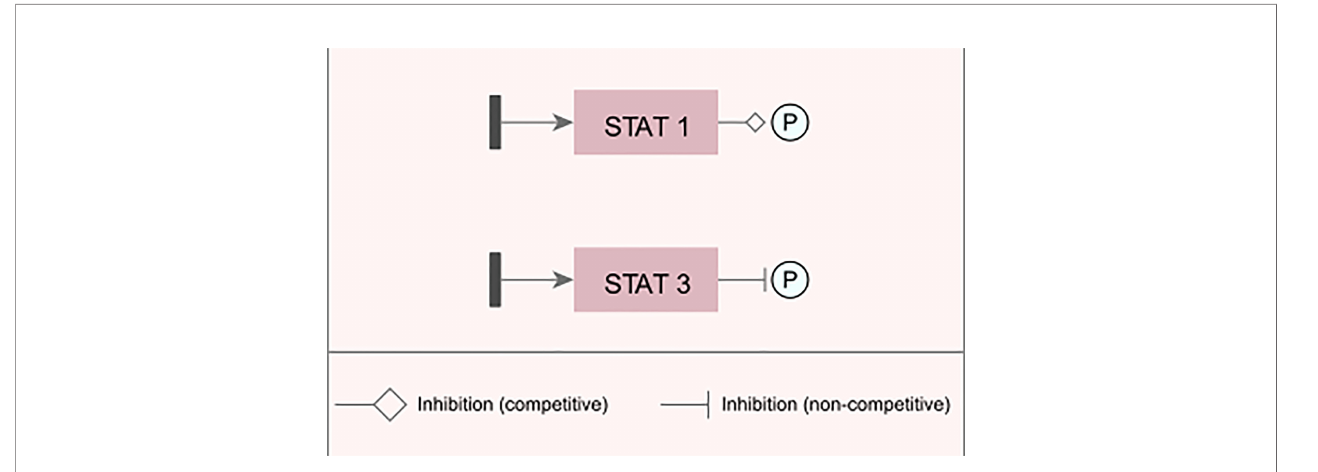
FIGURE 3 | Examples of changes inserted into the network. Examples of representation of inhibitory and/or blocking changes that were inserted into the modeled